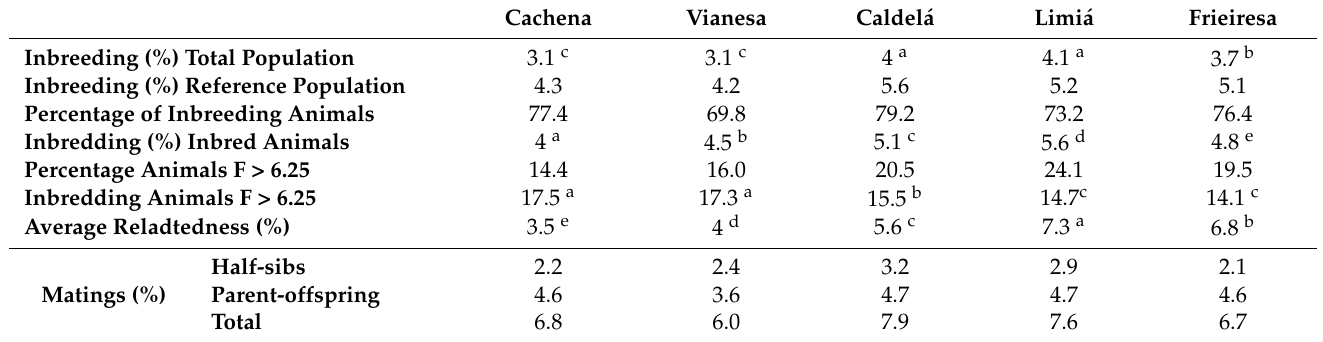
Table 2. Different Inbreeding and average relatedness parameters. Percentage of highly inbred mating in the five Galician bovine breeds. Different letters indicate statistically significant differences at p < 0.05. Reference population refers to those animals born since 2017 to